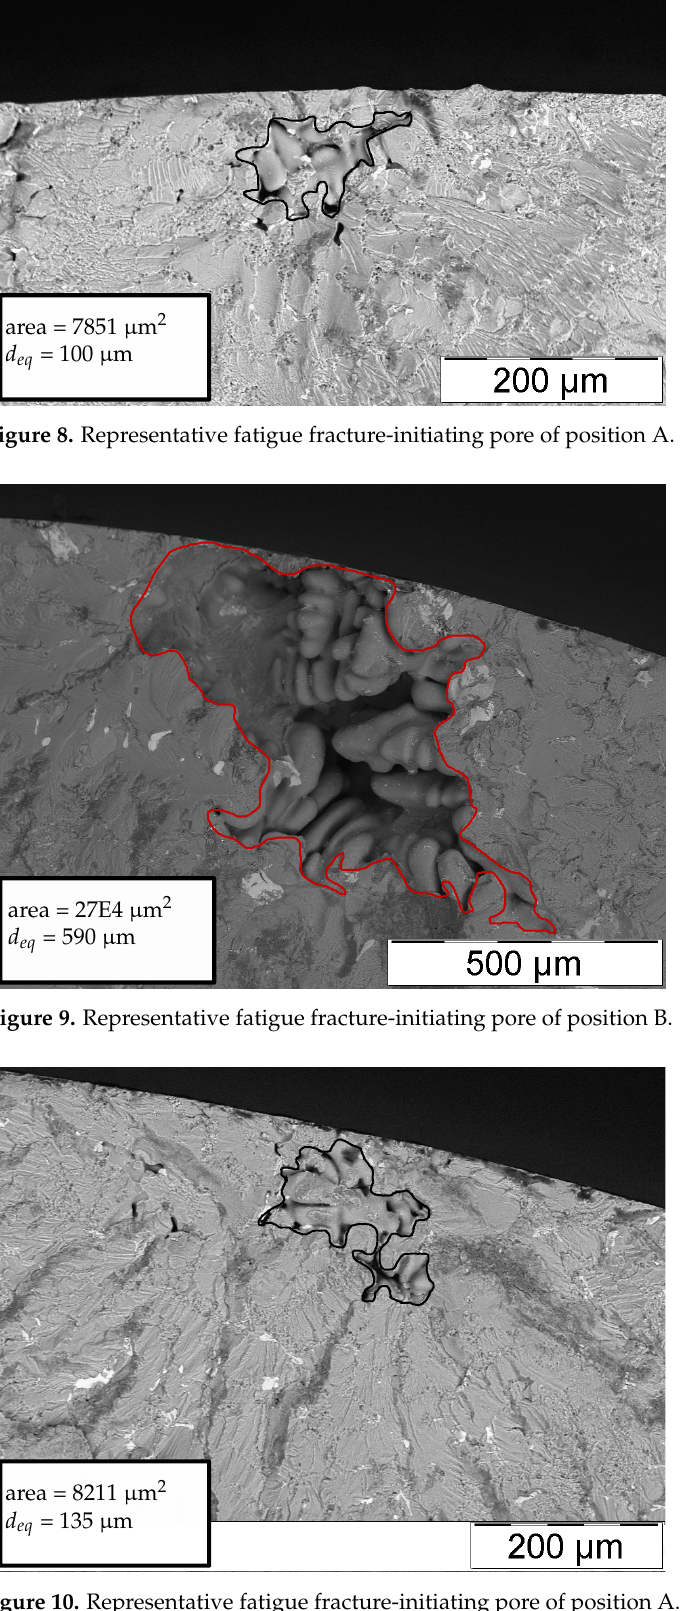
Figure 10. Representative fatigue fracture-initiating pore of position